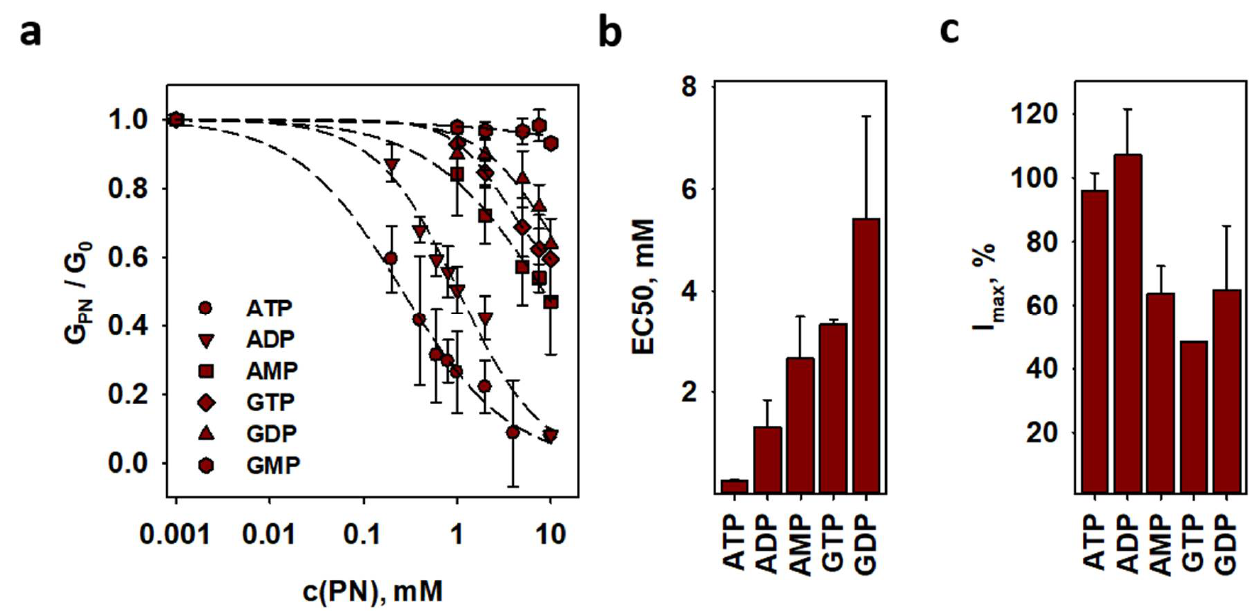
Figure 5. FA activated proton leak is preferably inhibited by ADP and ATP and maintains the substrate specificity of ANT. ( a ) Membrane conductance of lipid bilayers reconstituted with AA and ANT1 in the presence of different purine nucleotides. Lines are a least square regression fit of a sigmoidal function to the data. ( b ) EC50 and ( c ) maximum inhibition values as fit function parameters in ( a ). Values for GMP were dropped due to the low effect. For experimental conditions, see Figure 4. Data are the mean ± SD of at least three independent